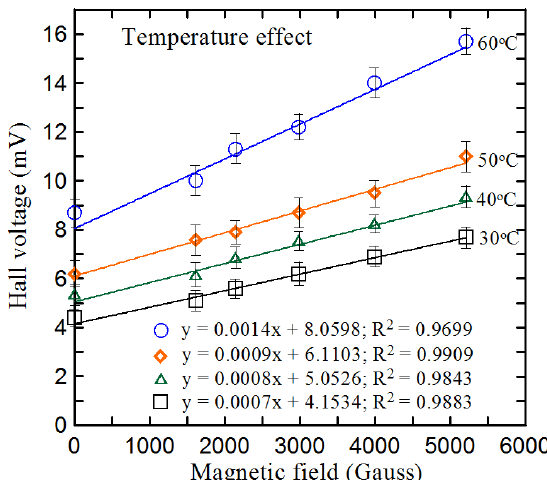
Figure 8. Magnetic hysteresis curve for the Hall sensor of size S at 10 mA of working current.